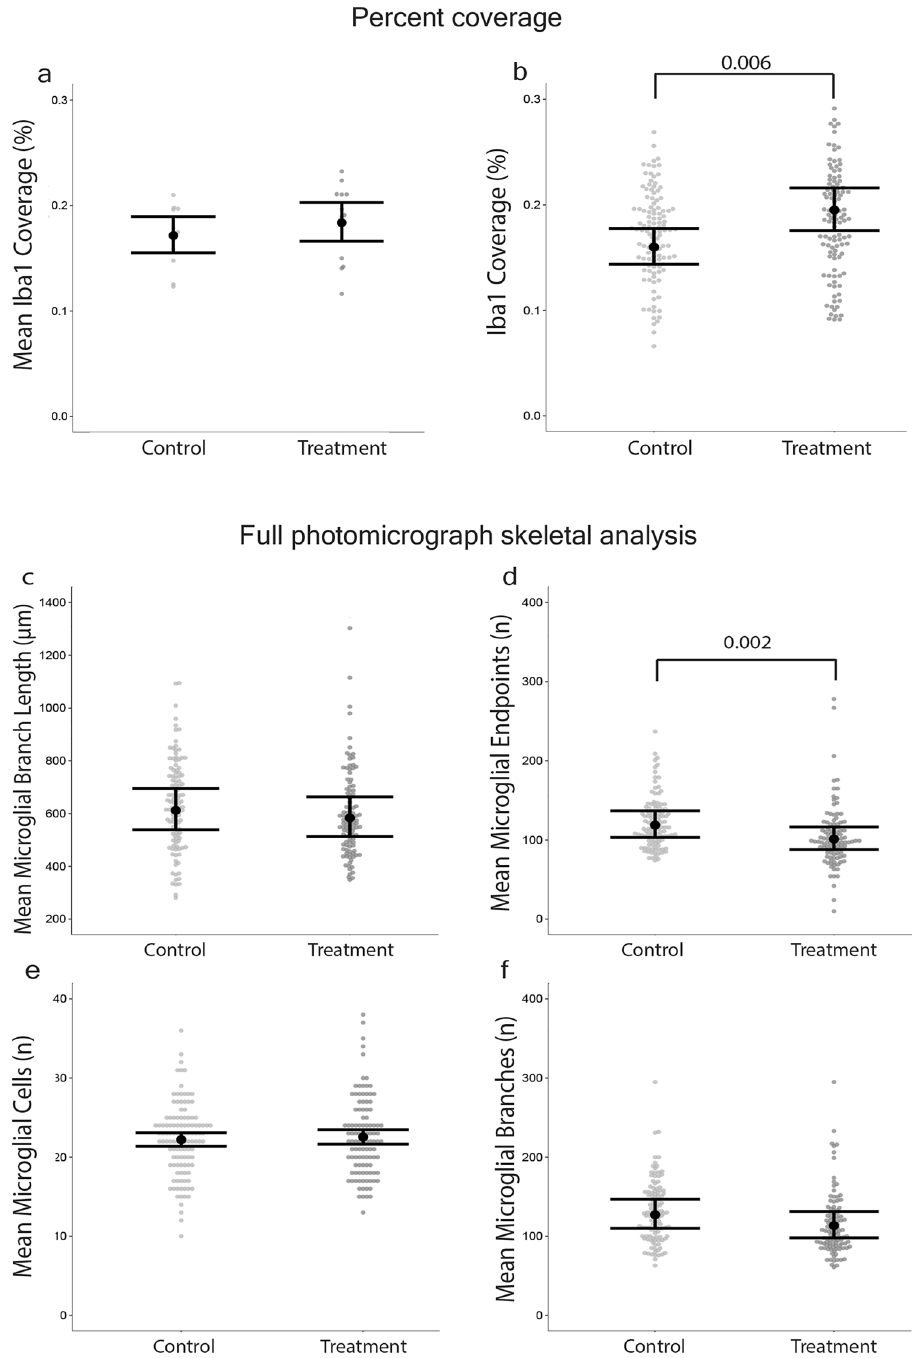
Figure 3. Full photomicrograph analyses of microglial morphology were not sensitive to differences between control and treatments groups. Photomicrograph-averaged Iba1 percent coverage masked a difference between control and treatment groups that photomicrograph-specific percent coverage detected. 3 brain slices per mouse and 3 photomicrographs per brain slice were used. ( a ) Mean percent coverage of Iba1 staining per animal. Treatment n = 12 mice, Control n = 13 mice. ( b ) Percent coverage of Iba1 staining, where individual data points (gray dots) were not averaged. Full photomicrograph skeletal analysis detected that microglia from the treatment group had fewer endpoints than the controls but did not detect differences in branch number or branch length. ( c ) Mean microglial branch length; ( d ) mean number of endpoints per cell per photomicrograph; ( e ) mean number of microglial cells per photomicrograph; and ( f ) mean number of microglial branches per cell per image. Individual data points are presented as gray dots. ( d – f ) Treatment n = 108 images (12 mice, 9 images/mouse), Control n = 117 images (13 mice, 9 images/mouse). Results are presented as point estimates with 95% confidence intervals, which were estimated from mixed effects models with a negative-binomial error